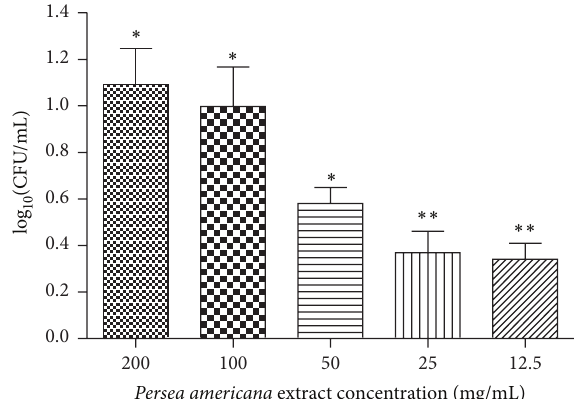
Figure 2: Reduction of C. albicans biofilm in the treated groups ( 𝑛 = 10 ). ∗ Reductionstatisticallysignificant. ∗∗ Reductionnotstatistically